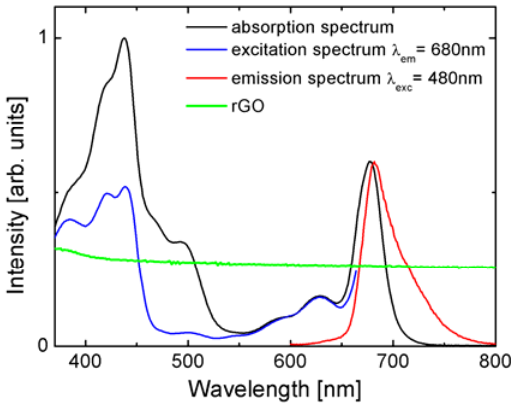
Figure 1. Absorption (black line), fluorescence (red), and fluorescence excitation (blue line) spectra of photosystem I (PSI) complexes in a buffer solution. Green line corresponds to the absorption of the reduced graphene oxide (rGO) layer.